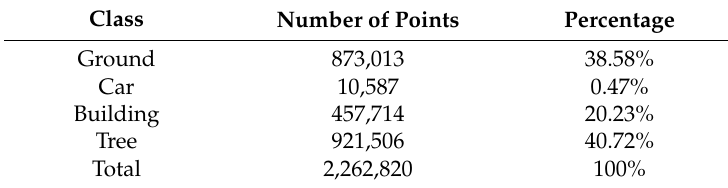
Figure 2. Test area for the airborne laser scanning (ALS) point cloud dataset: ( a ) Point cloud data (displayed by intensity); ( b ) Labelled categories. Table 3. Number of points and percentage of each class for ALS point cloud.